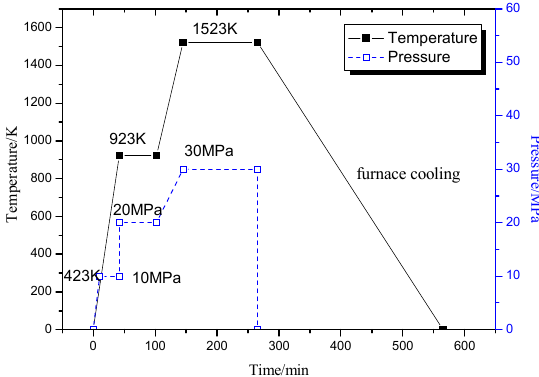
Figure 1. Time/temperature/pressure pro fi le used in the reactive sintering of the mixed powders.